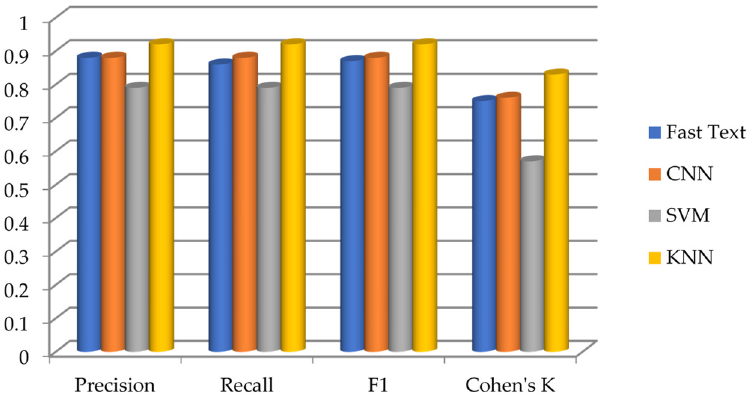
Figure 3. Graph of overall results of the validation set for all classifiers using a dataset of 10 6 samples.